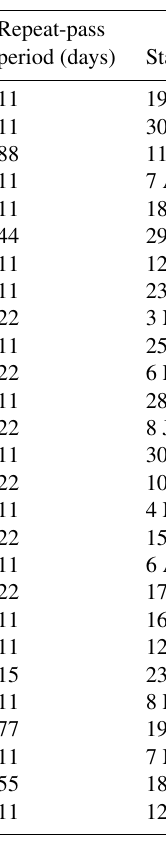
Table 1. TerraSAR-X acquisitions of Basin 3 and repeat-pass peri-